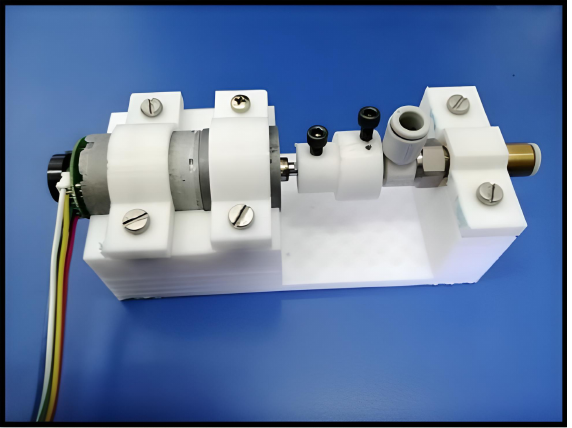
Figure 5. Airflow control system valve with plastic base for DC motors.